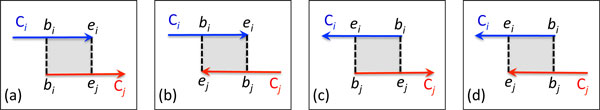
Possible extension alignments between Ci and Cj. Arrows stand for contigs' orientation, b and e stand for beginning and end coordinates of the alignment on each contig. Reverse cases are not depicted (i.e. where b and e positions are inverted).